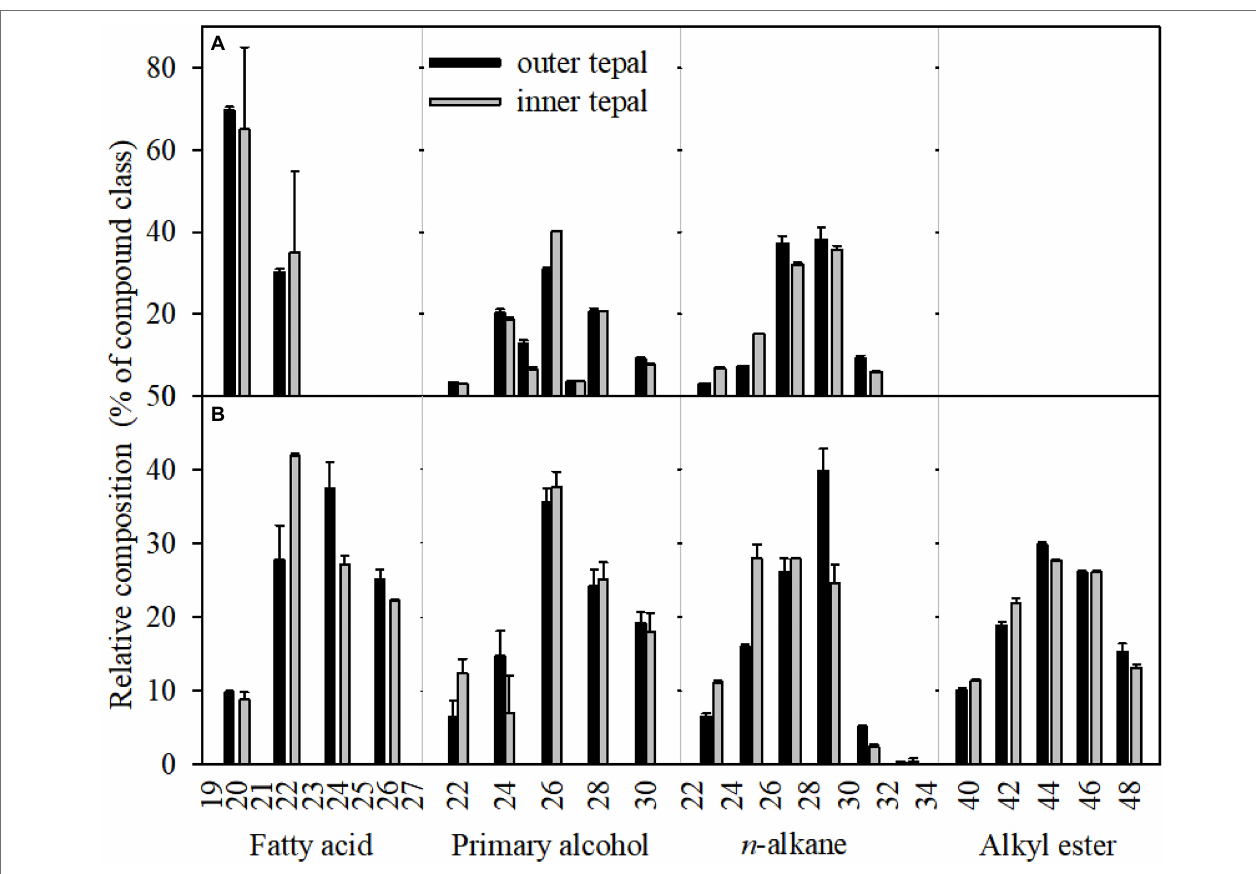
FIGURE 5 | Carbon chain-length distribution of the cuticular waxes on the tepals of green buds (A) and open flowers (B) of the Lilium cultivar ‘Casa Blanca’. Data are presented as the mean ± standard deviation ( n =